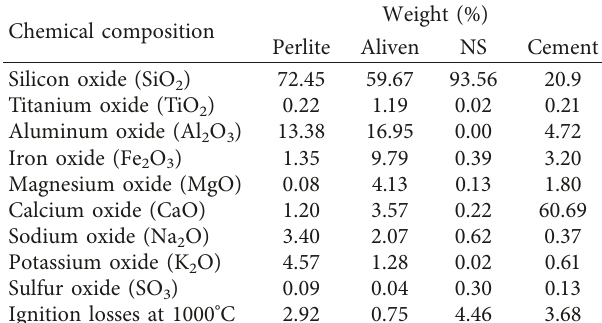
Table 1: Chemical composition of